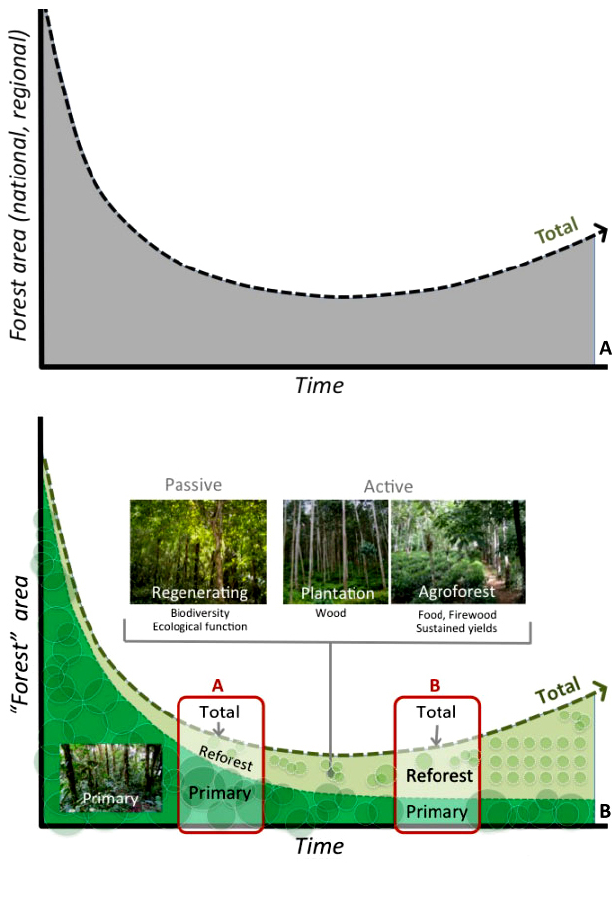
Fig. 1 . The forest transition. (A) The classic forest-transition curve, depicting a decrease in forest area over a given geographical area (continental, national, or regional), followed by an increase as forests return. (B) The distinction between primary and secondary forests, and the relative amounts of each at the forest-area inflection point. Note that point A represents a transition with a relatively high proportion of primary forest remaining, whereas at point B, most forests on the landscape are